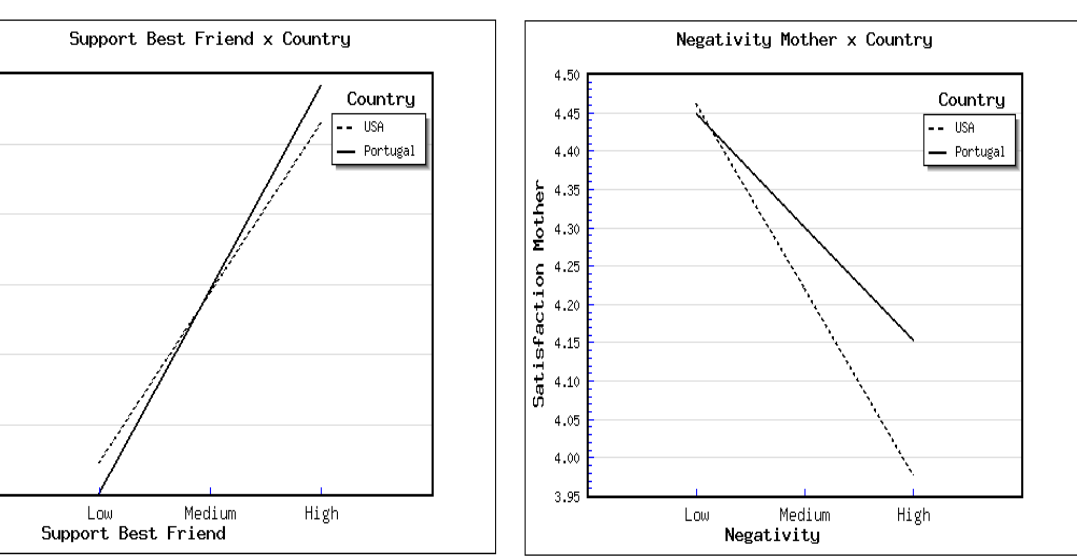
Figure 1. The influence of perceived negativity in the relationship with the mother and of perceived support from the same-sex best friend in perceived relationship satisfaction, depending on country.